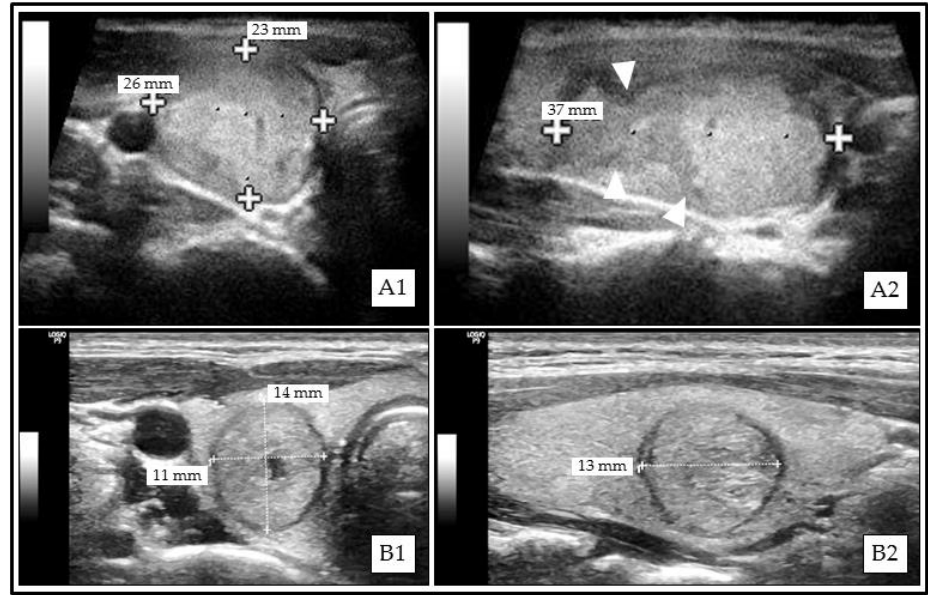
Figure 1. Examples of thyroid nodules (TNs) that could not be classified according to American Thyroid Association (ATA) Guidelines. ( A1 ) (transversal)/( A2 ) (sagittal): Solid isoechoic papillary thyroid carcinoma (PTC) with irregular margins ( A2 , white triangle markers). ( B1 ) (transversal)/( B2 ) (sagittal): Mainly solid isoechoic benign (Bethesda II) thyroid nodule (TN) with taller-than-wide (TTW) shape.